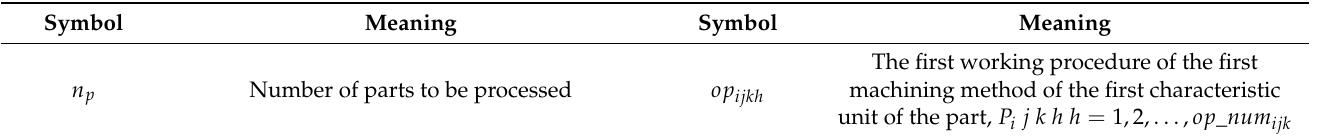
Table 3. Related parameters and definitions in the